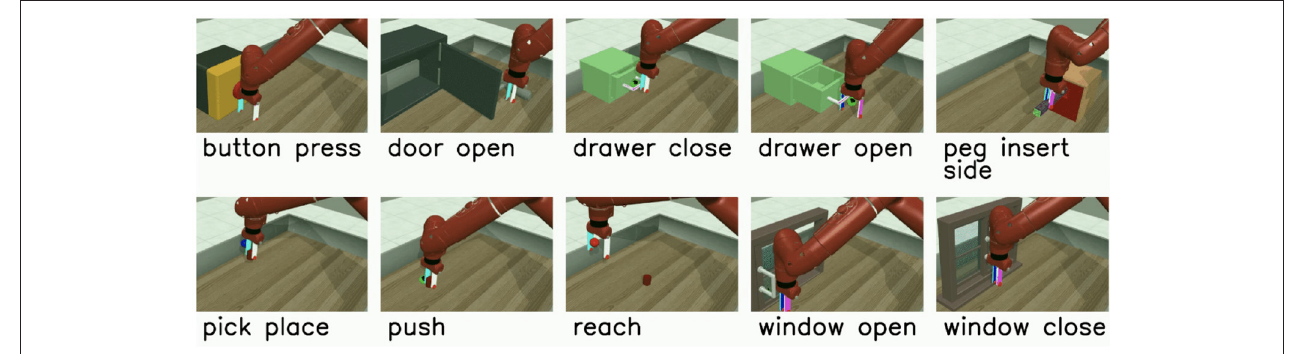
FIGURE 3 | The Meta-World v2 Multi-Task 10 (MT10) environment, where a single robotic arm must learn to solve a variety of tasks ranging in